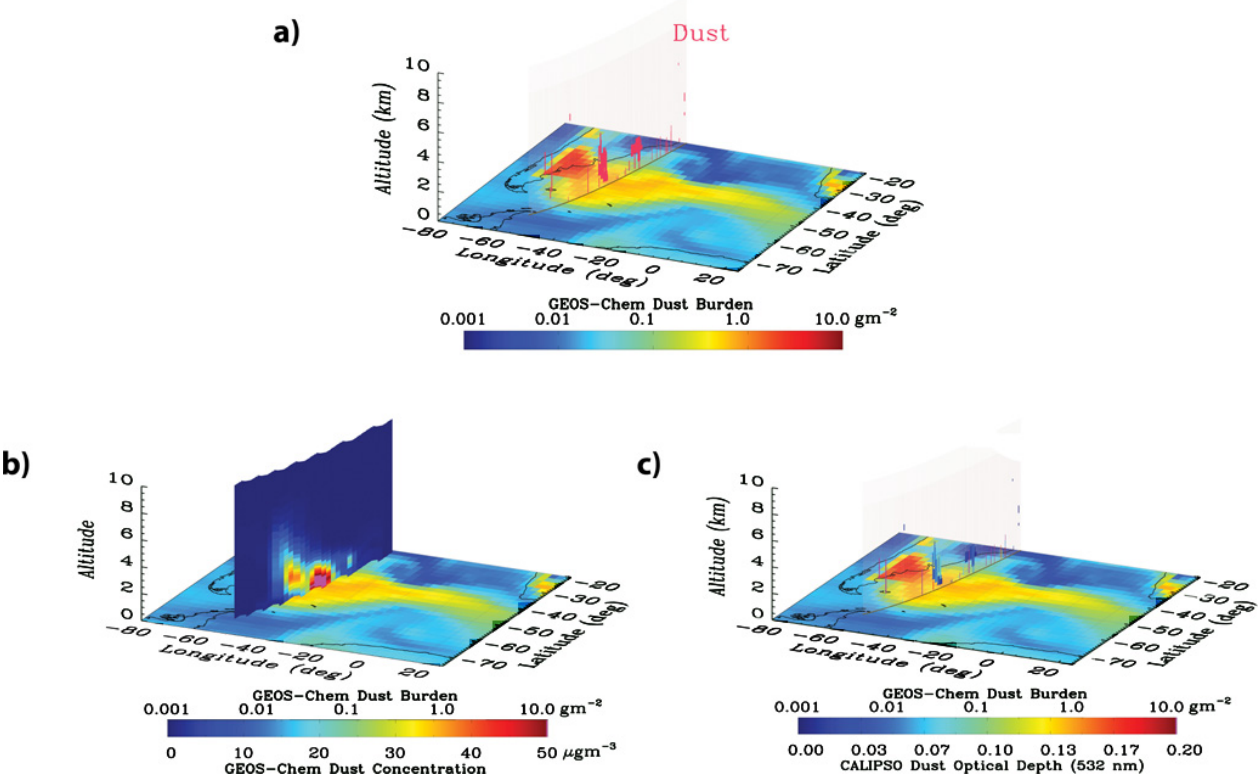
Fig. 4. Same as Fig. 3 but for 24 January 2009 and the CALIPSO orbital track beginning at 03:33:27UTC